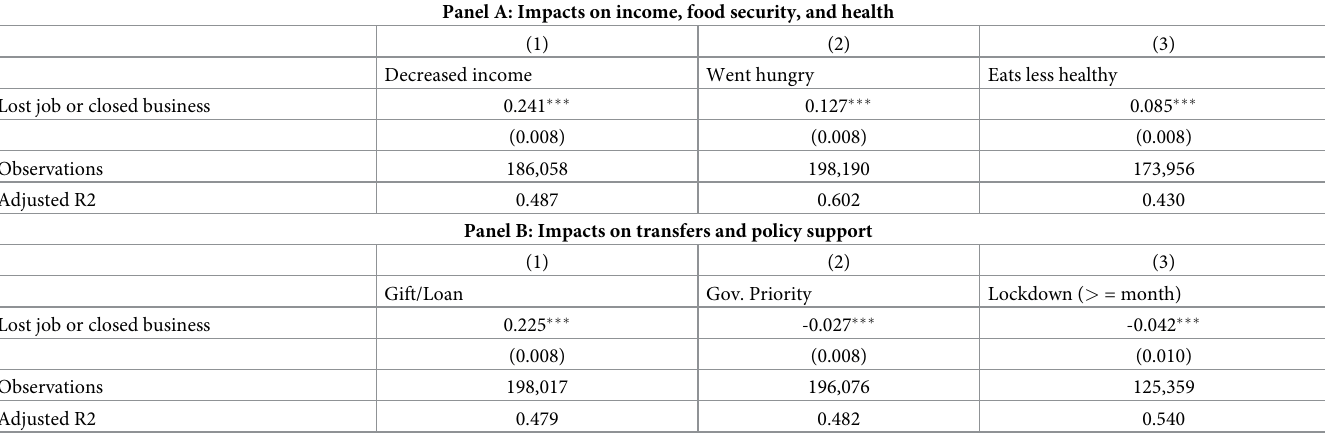
Table 1. The loss of livelihood during the pandemic is linked to changes in nutrition and policy support.